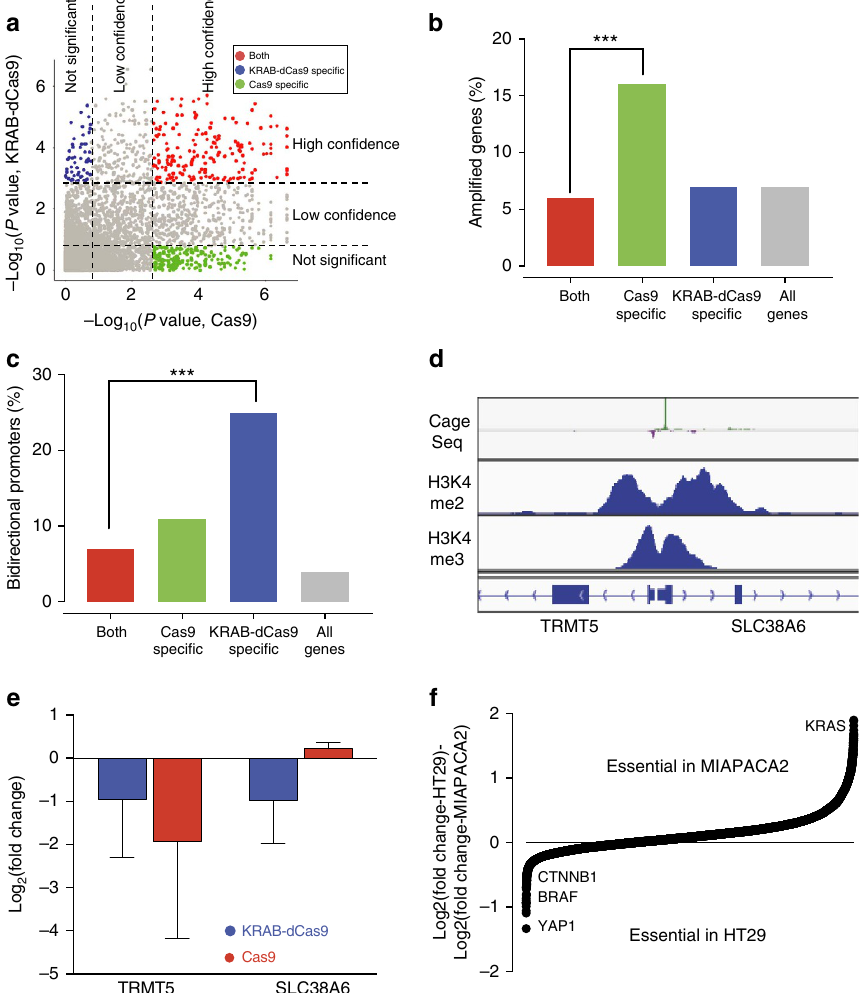
Figure 3 | Genome scale CRISPRi proliferation screens. ( a ) MAGECK 22 was used to identify statistically significant cell essential genes in HT29 cells expressing Cas9 or KRAB-dCas9. Genes scored to be essential were categorized into three groups: ‘both’ (essential in both Cas9 and KRAB-dCas9), ‘KRAB-dCas9 specific’ and ‘Cas9 specific’. ( b ) The percentage (%) of amplified genes in three categories. *** P o 0.001, Fisher’s exact test. ( c ) The percentage (%) of genes containing bidirectional promoters in three categories. *** P o 0.001, Fisher’s exact test. ( d ) Peaks of cage-seq (from ref. 16) and ChIP-seq peaks of H3K4-me2 and H3K4-me3 in the promoter region of TRMT5 and SLC38A6 . ( e ) Proliferation changes induced by KRAB-dCas9 (blue) or Cas9 (red) in HT29 cells. Error bars represent deviation from the mean of all sgRNAs targeting the indicated genes. ( f ) Comparison of genetic dependencies between HT29 and MIAPACA2 cells expressing KRAB-dCas9. Genes are ranked based on the Log2[FC] difference between MIAPACA2 and HT29 cells. All FCs are presented as the mean of duplicate